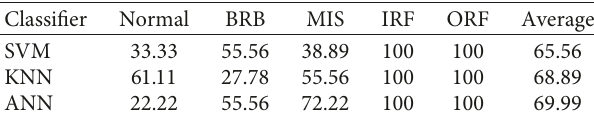
Table 8: Classification accuracy of the vibration signal by different classifiers (%).